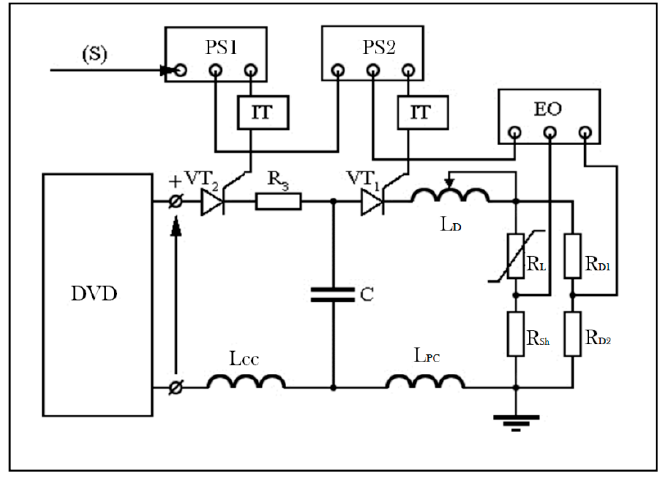
Figure 4. The electrical circuit of the experimental low-voltage source of discharge currents.